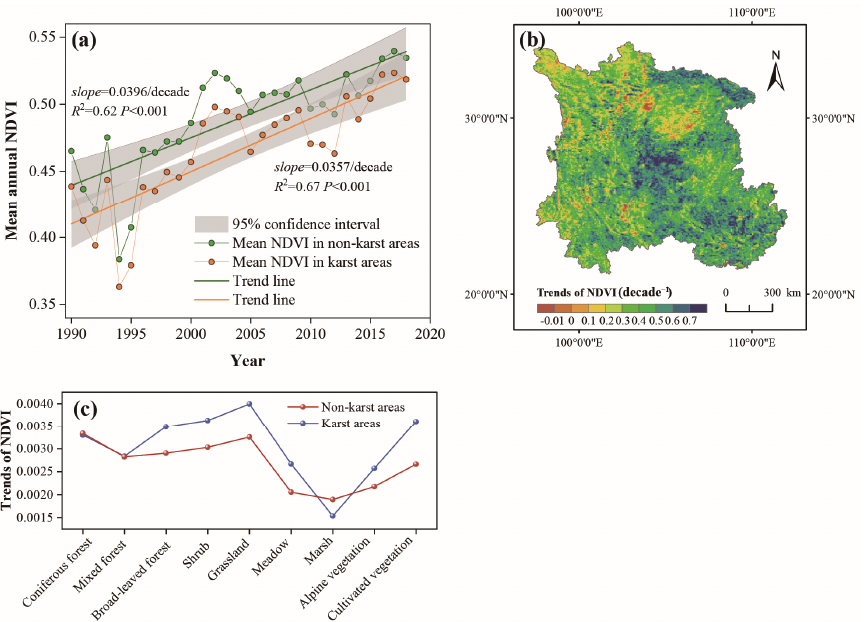
Figure 6. ( a ) Temporal change trends in interannual mean NDVI from 1990 to 2018. ( b ) Spatial change trends in interannual mean NDVI from 1990 to 2018. ( c ) The mean change trends of different vegetation types in karst and non-karst areas from 1990 to 2018.